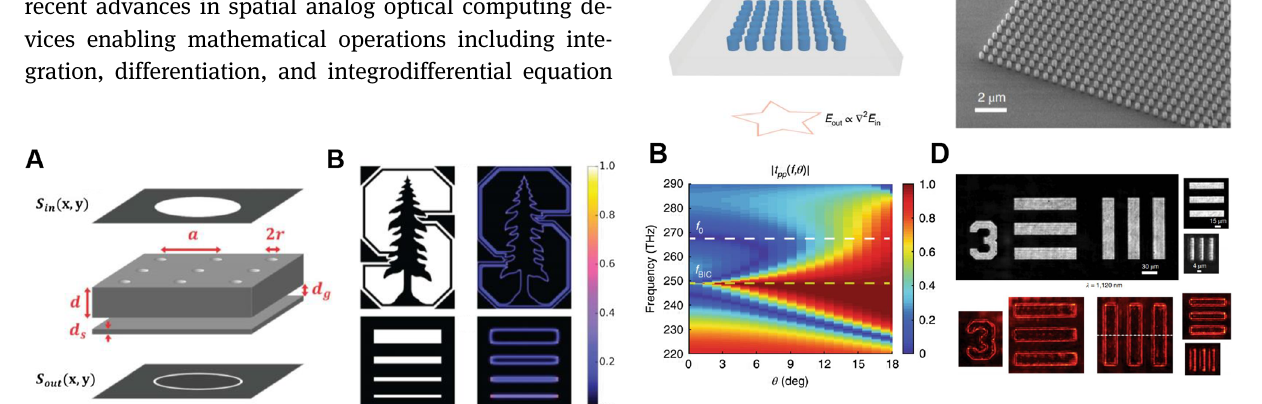
Figure 12: (A) The schematic of the photonic crystal structure for Laplacian differentiation consisting of a photonic crystal slab separated from a uniform dielectric slab by an air gap [56]. (B) Incident Stanford emblem (top left panel) and calculated transmitted image with unpolarized light (top right panel). The spatialresolutionofthedifferentiatorisshowninthebottompanels (incident slot patterns in the left and calculated transmitted images with unpolarized light in the right).